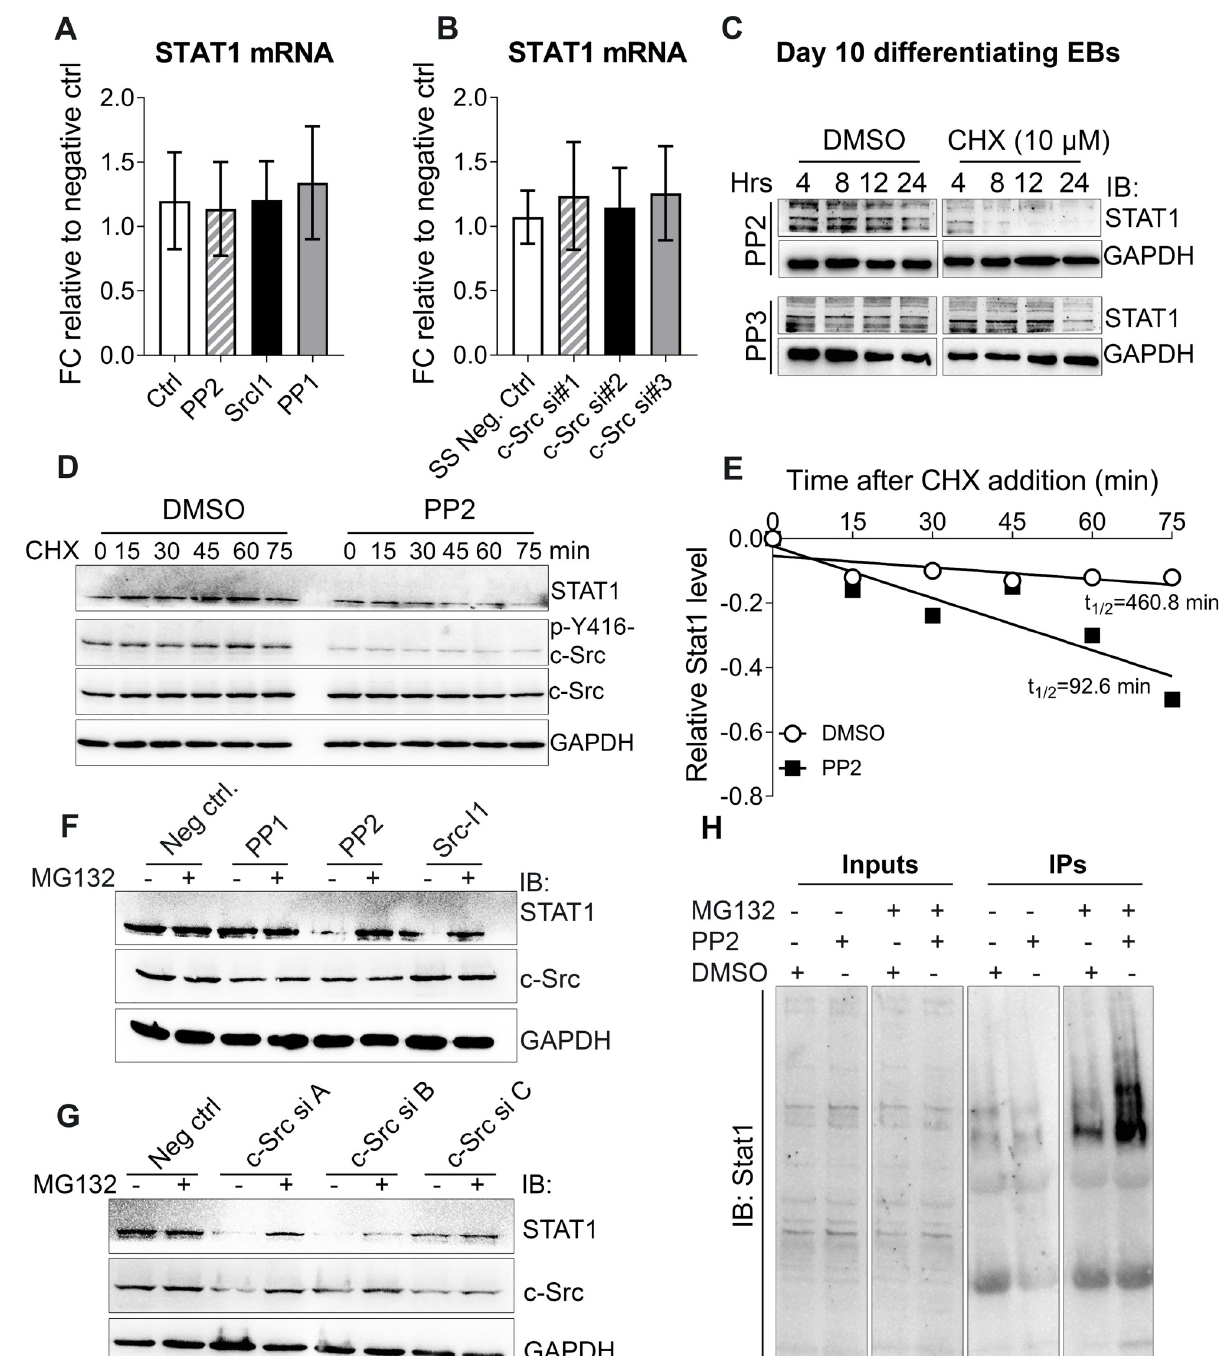
Fig 4. c-Src enhances STAT1 protein stability. (A and B) Real time qPCR analysis of STAT1 expression upon pharmacological inhibition of c-Src using 10 μ M of PP1, SrcI-1, and PP2 for 2 hours where DMSO served as negative control (A) and c-Src downregulation using with three different distinct siRNAs where silencer ™ select negative siRNA served as control for 48 hours (B) in MC3T3E1 cells. Data shown represent the means ( ± SD) of triplicates. (C) c-Src inhibition and its effect on STAT1 protein level in mESCs. Differentiating EBs were exposed to 10 μ M of PP2 or PP3 for 24 hours prior to treatment with CHX (10 μ M) or DMSO. Lysates were collected at the indicated times and subjected to WB analysis using STAT1 antibody. GAPDH served as loading control. (D) Inhibition of c-Src activity and its effect on STAT1 half-life in MC3T3-E1 cells. Cells were subjected to PP2 (10 μ M) or DMSO (solvent ctrl) treatments for 2 hrs, prior to addition of CHX (10 uM). Harvested cells at the indicated time points were subjected to WB analysis to examine STAT1 expression. GAPDH served as a loading control. (E) Quantification of STAT1 stability assays. STAT1 band densities were quantified, first normalized to the corresponding GAPDH and then to t = 0 DMSO controls. (F and G) Inhibition of proteasomal degradation by